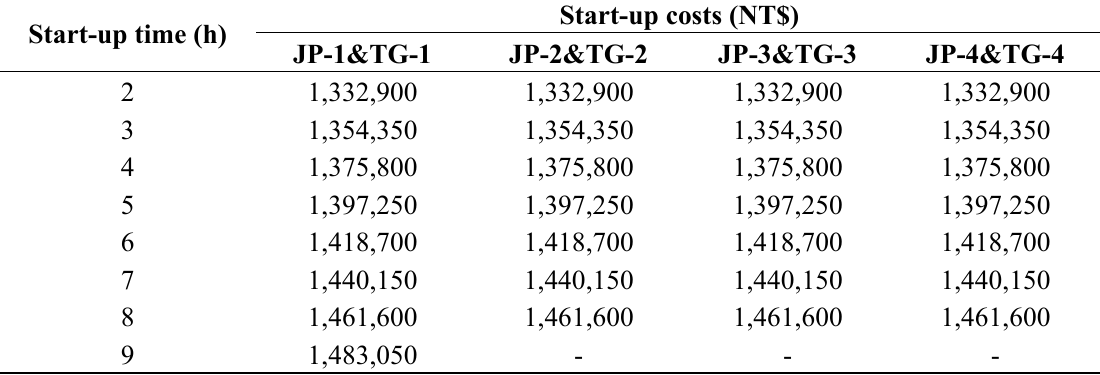
Table 4. Comparison of start-up costs between four generating units in the studied plant. Start-up time